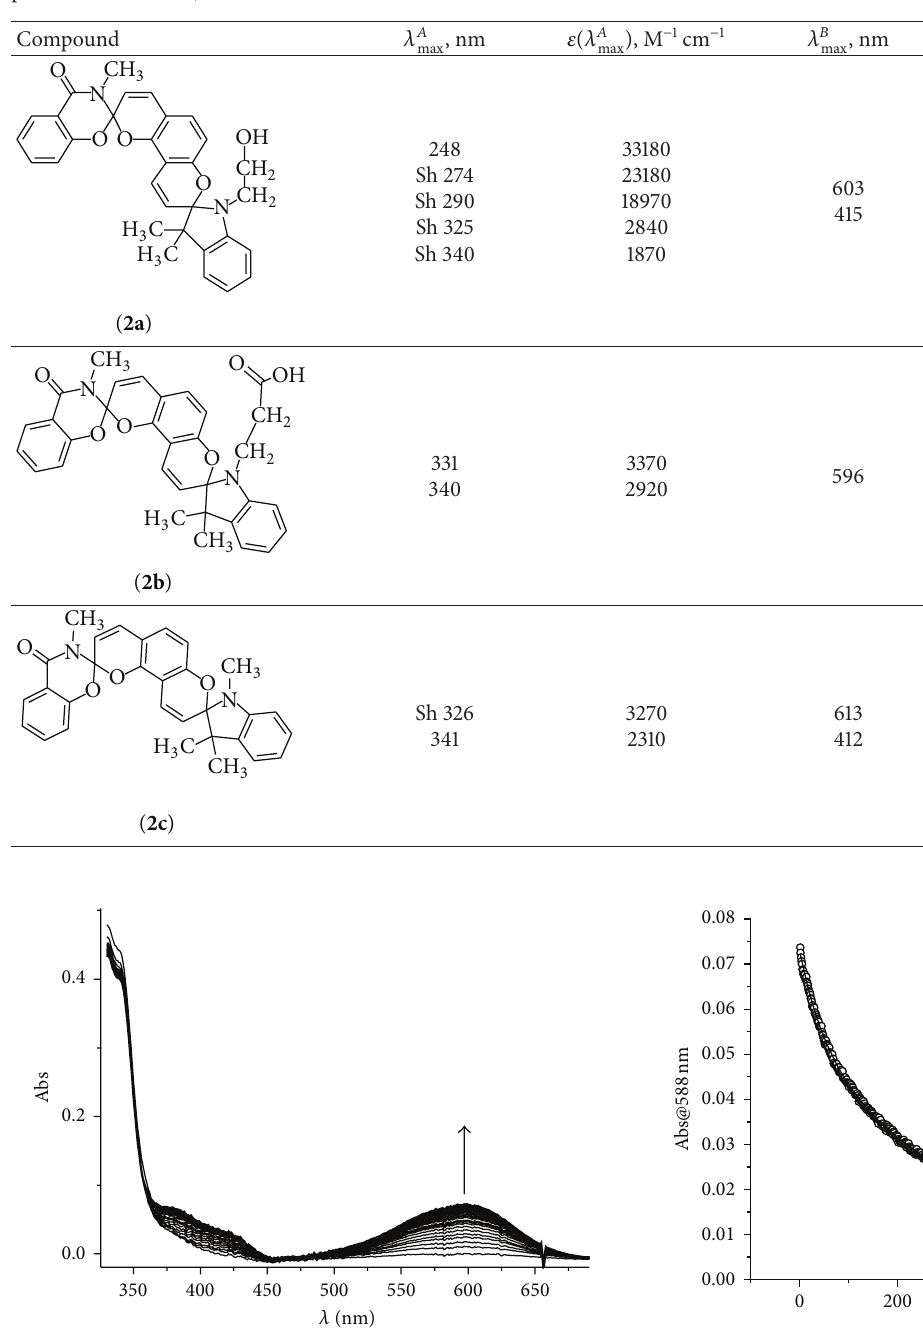
Table3:Spectralandkineticpropertiesofthebis-spiropyrans( 2a – c )( 𝜆 𝐴 max , 𝜀(𝜆 𝐴 max ) areparametersoftheabsorptionspectrabeforeirradiation (i.e., characteristics of the spirocyclic isomers); 𝜆 𝐵 max is positions of the longwave maxima generated under irradiation; 𝜏 𝐵 20 is lifetime of the photoinduced forms).